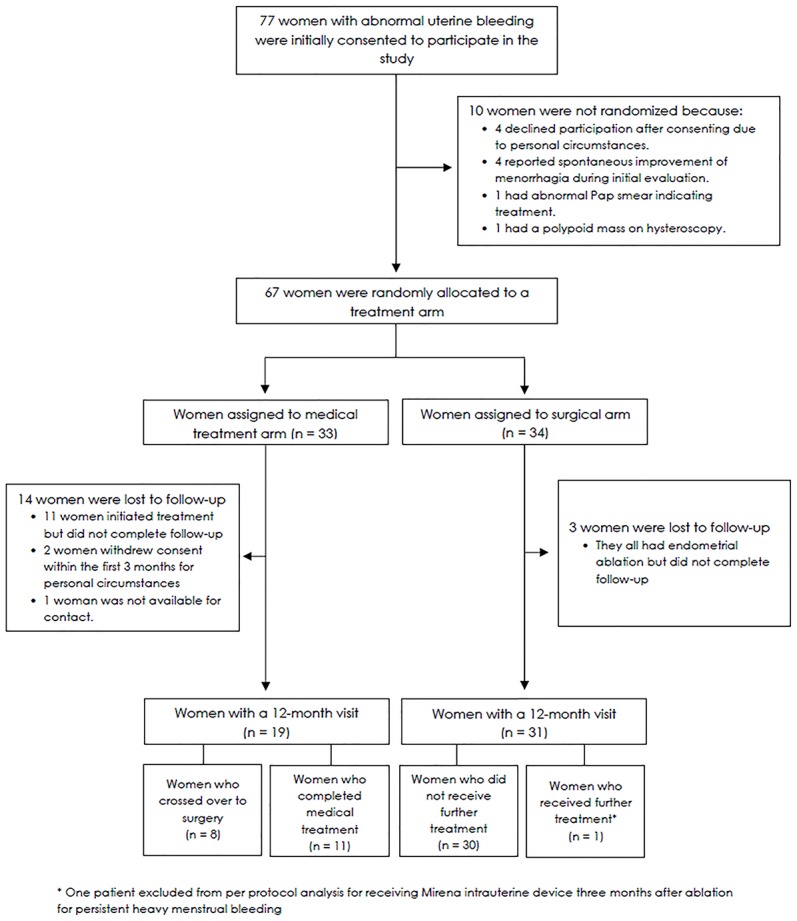
Study flow chart.